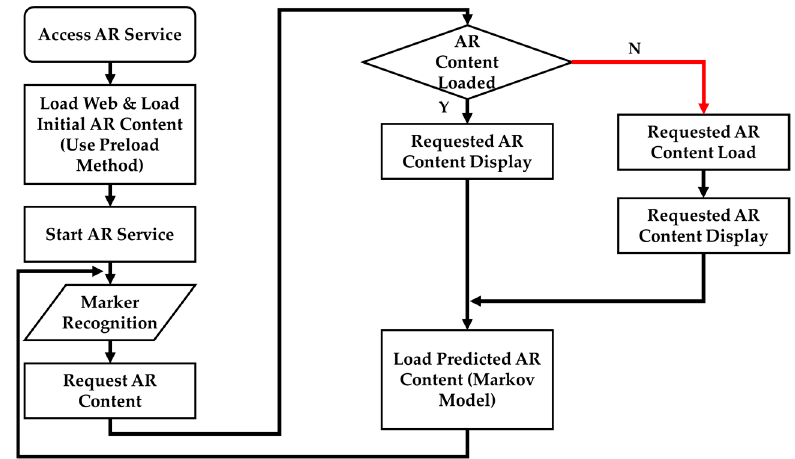
Figure 5. Client flowchart.